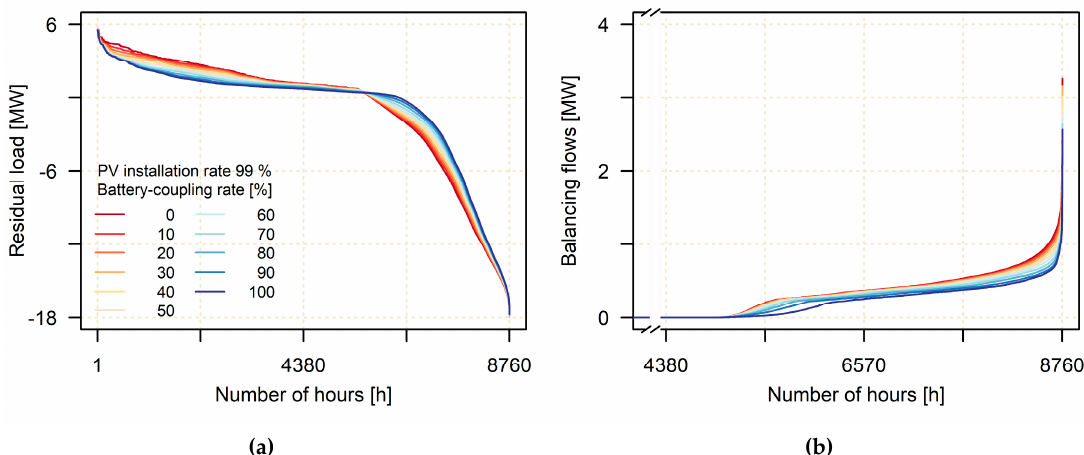
Figure 8. Duration curves of ( a ) residual loads and ( b ) balancing flows for different battery-coupling rates at a PV installation rate of 99%.